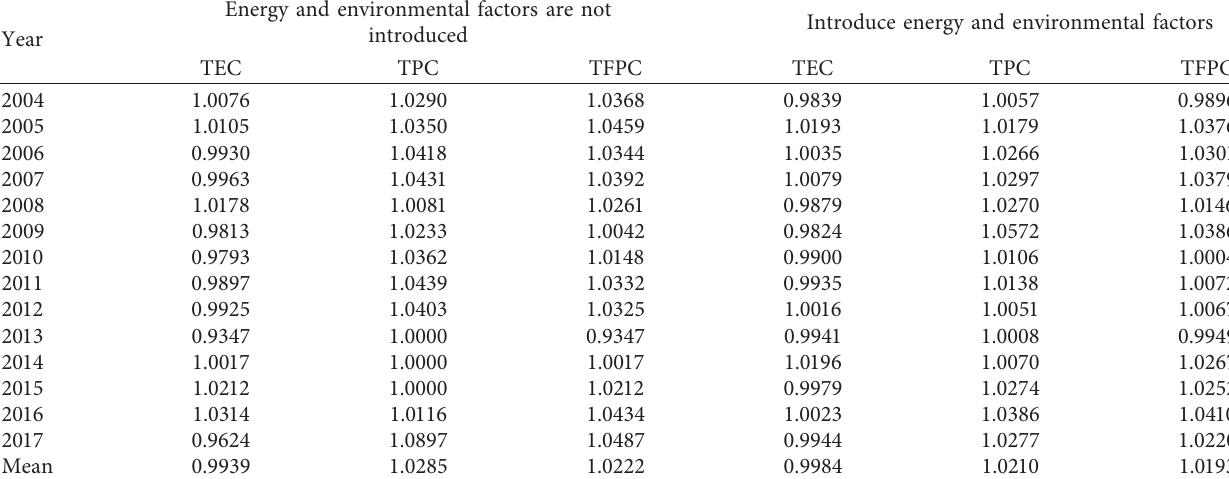
Table 3: TFP index of logistics industry and its decomposition